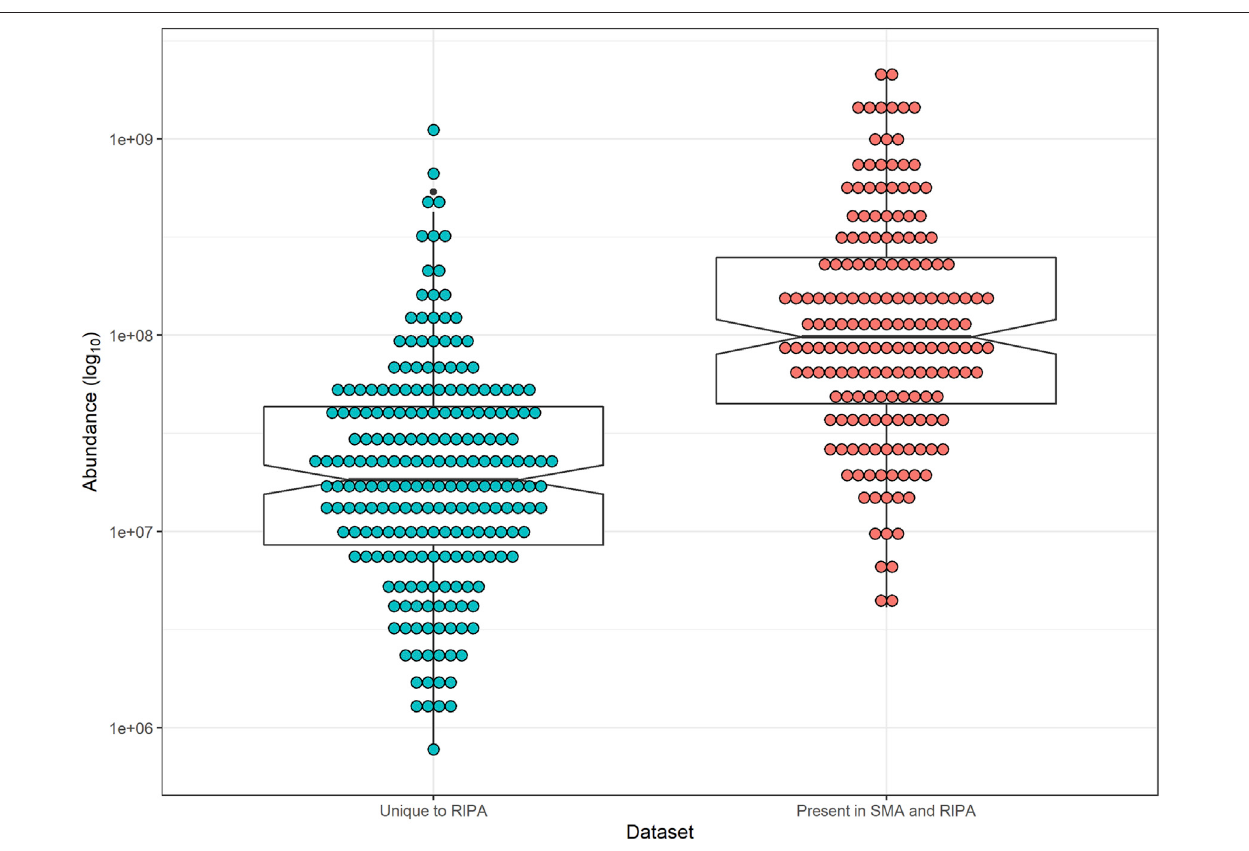
FIGURE 8 | Notched-box plot showing abundance of peptides from TM proteins in pull-downs from RIPA extract. Median and interquartile range are shown. Notchesindicate95%con fi denceintervalofmedian.(Blue)TMproteinsuniquetopull-downsfromRIPAsupernatantsandthosepresentinSMA(Red).Abundance(area values) were from the pull-downs from RIPA extracts (wash protocol 3, Supplementary Table S1 , Tab S). Comparison between TM unique to RIPA and those in common with SMA, two-tailed t -test ( p -value (cid:2) 1.24 × 10 – 10